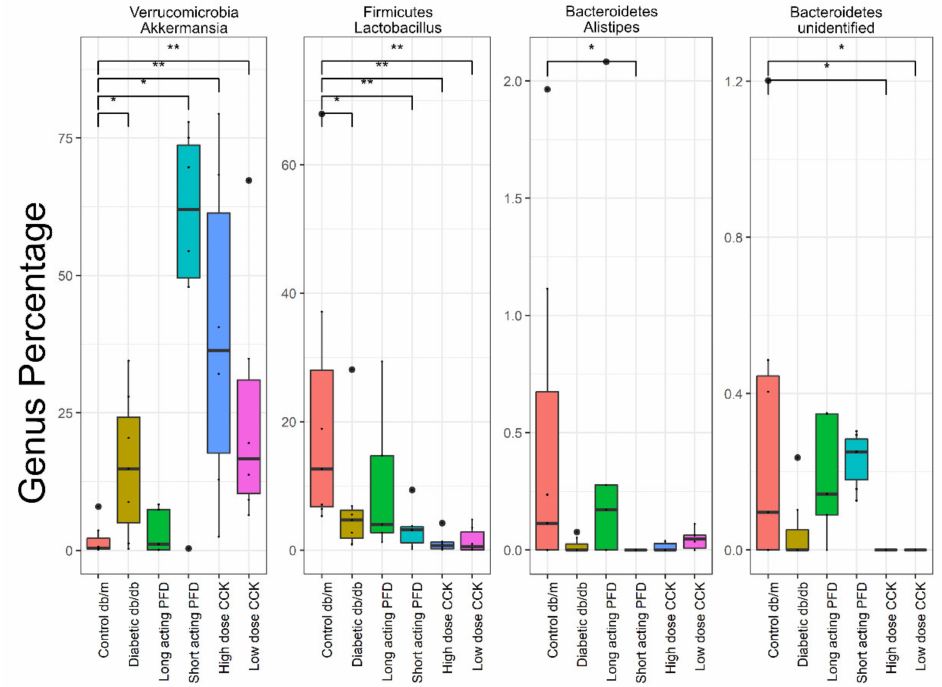
Figure 5. Selected genera with abundance levels comparable in long-acting PFD and control db / m cases obtained with DESeq2 with FDR less than 0.05. Significance levels between two groups is indicated by stars (* 0.01 to 0.05, ** 0.001 to 0.01) and no comparison / stars mean no statistical significance was found between